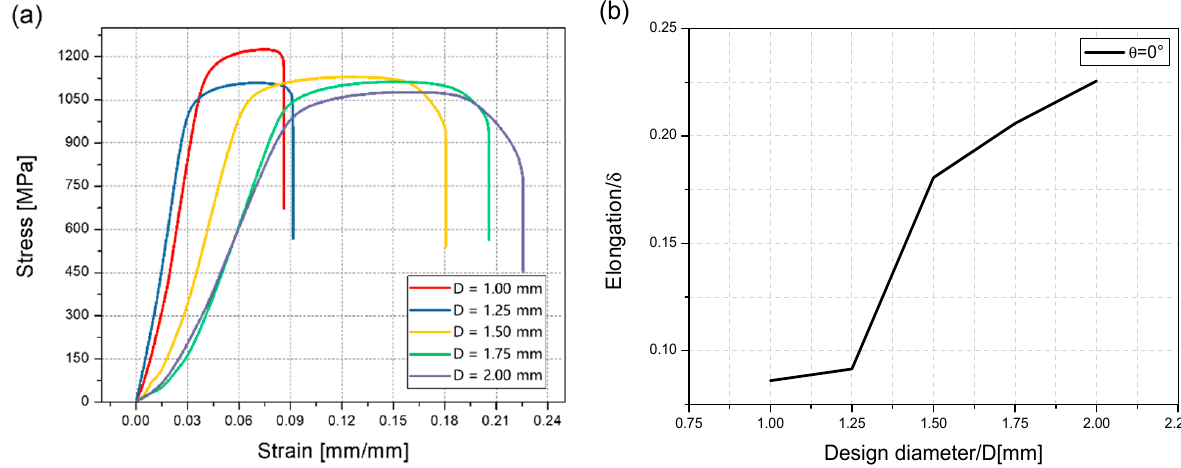
Figure 10. ( a ) Stress–strain response of the RB sample with inclination angle of 0°. ( b ) Elongation–Design diameter response of the RB sample with inclination angle of 0°.